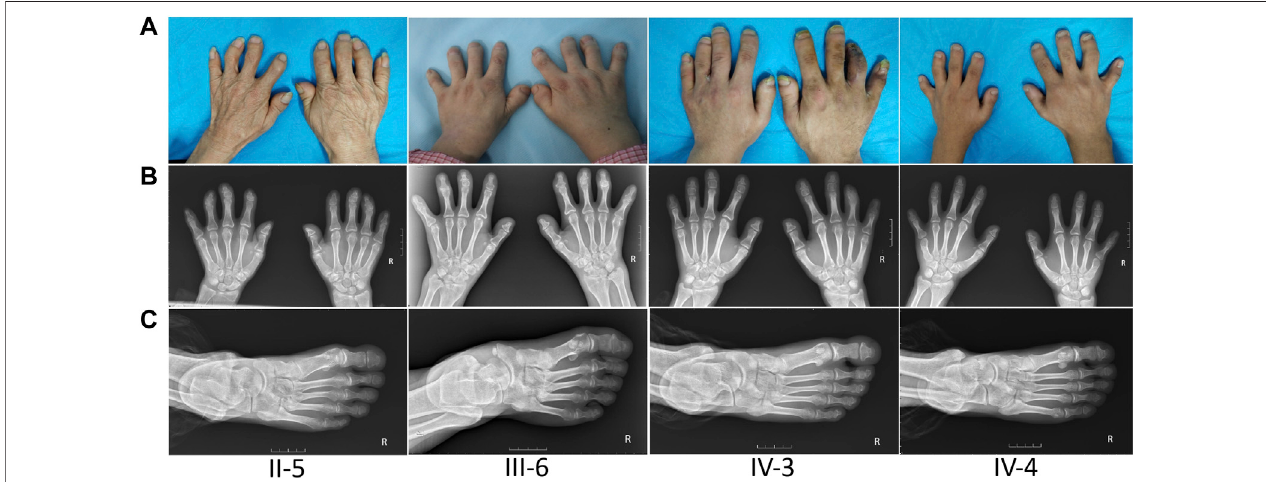
FIGURE1| Appearanceandradiological fi ndingsofotherfamily members withBDA1. (A) Shortened fi ngersandradialdeviationofotheraffectedindividualsinthis family. (B) Radiographic images of other patients ’ hands: absence of middle phalanges of the second, fourth, and/or fi fth fi ngers (II-5, II-6, IV-3, IV-4) in both hands, and the middle phalanges of the second fi nger of the right hand were fused to the distal phalanges (IV-4). (C) Radiographic images of other patients ’ right foot: abnormally shortened toes and the absence of phalanges.